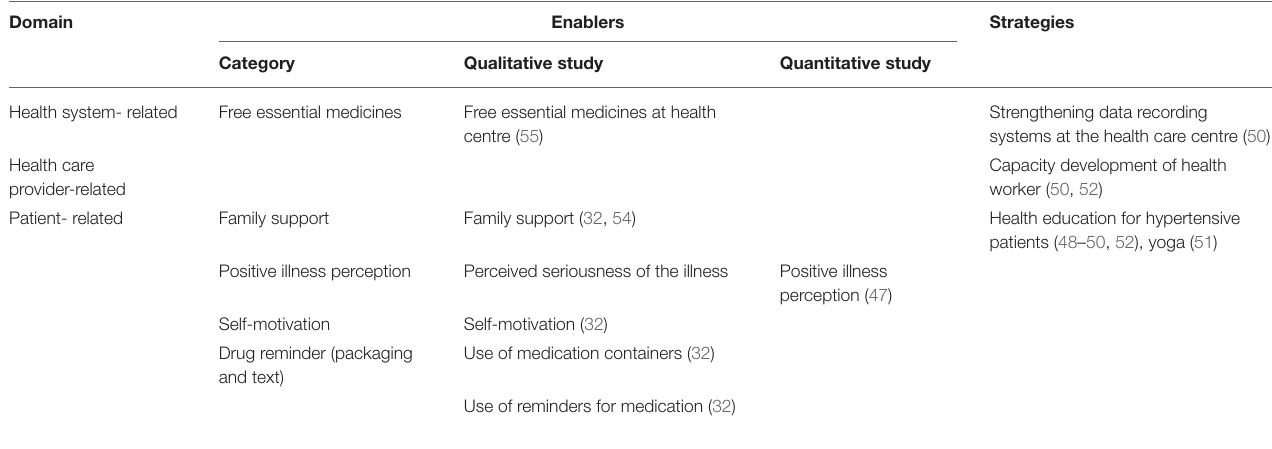
TABLE 2 | Enablers and strategies for hypertension treatment and control in Nepal.